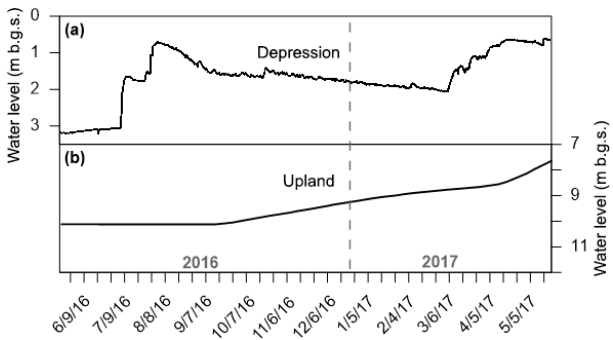
Figure 10. Groundwater levels in piezometers at Spyhill (a) depres- sion GP and (b) the upland from June 2016 to mid-May 2017. The grey dashed line indicates the beginning of